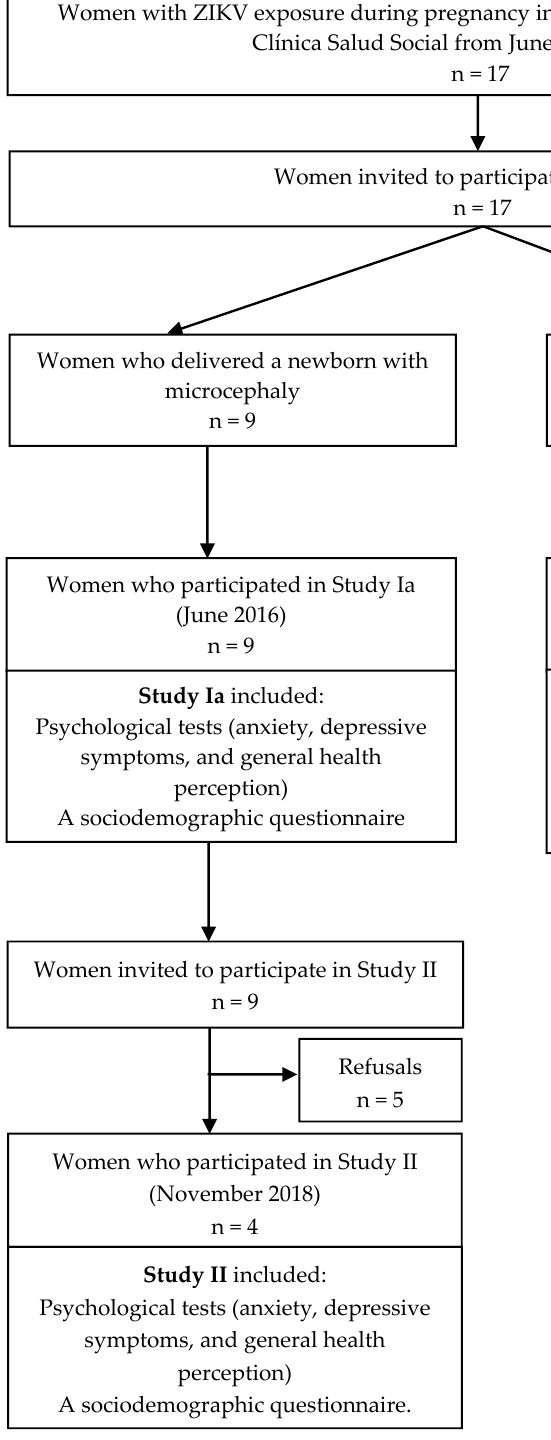
Figure 1. Patient flow chart of maternal enrolment in Zika virus study in Sucre, Colombia in 2016 and 2017.